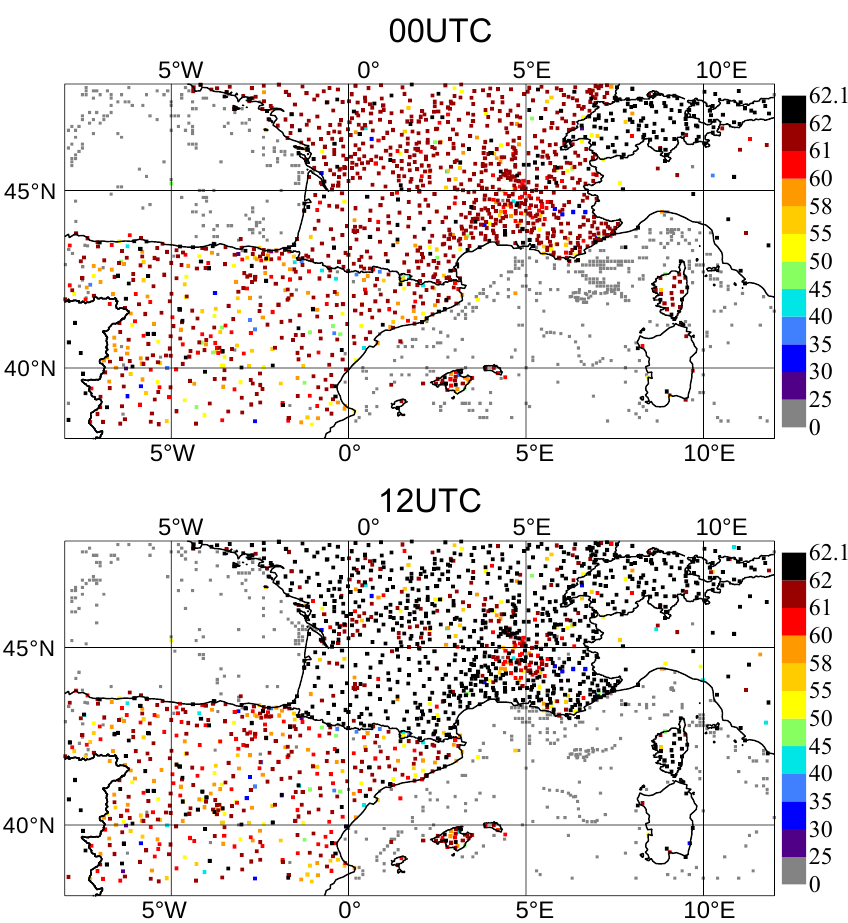
Figure 6. Number of days for which 2m temperature data were available for the period between 05 September and 06 November 2012 at 00:00UTC (top) and 12:00UTC (bottom) in the HyMeX